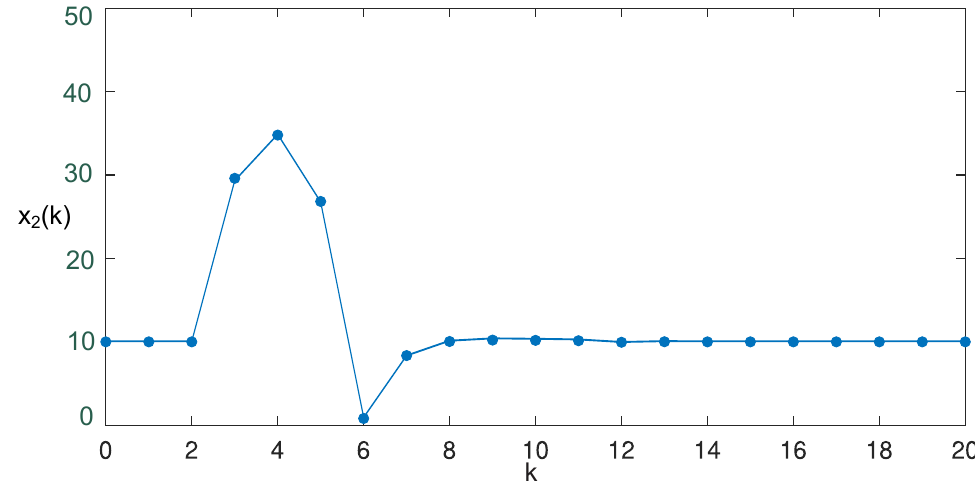
Figure 3. The 1th distributor’s actual inventory. Fig. 8. Response of the designed closed-loop output-feedback control Fig. 5. State-feedback closed-loop response to the impulsive distur- bance w ( k ) in Fig. 2 (top-left panel).